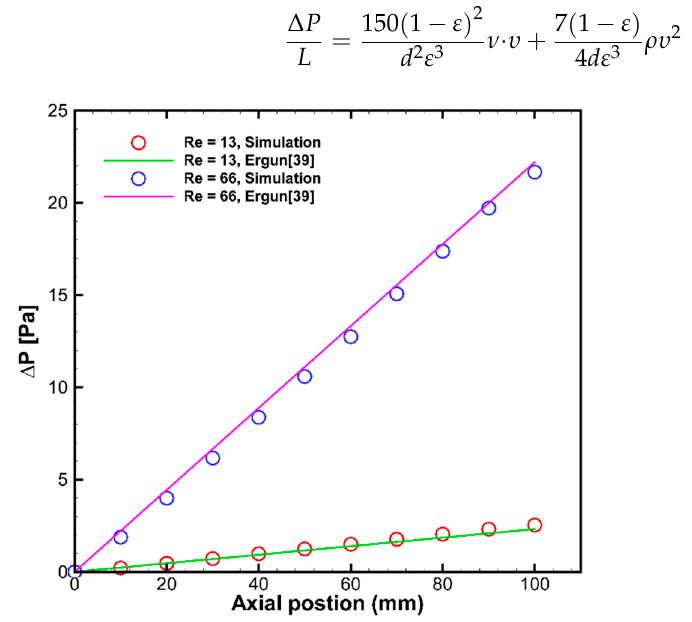
Figure 9. Comparison of the axial pressure drop for simulation with the Ergun [39] correction at various Reynolds numbers.